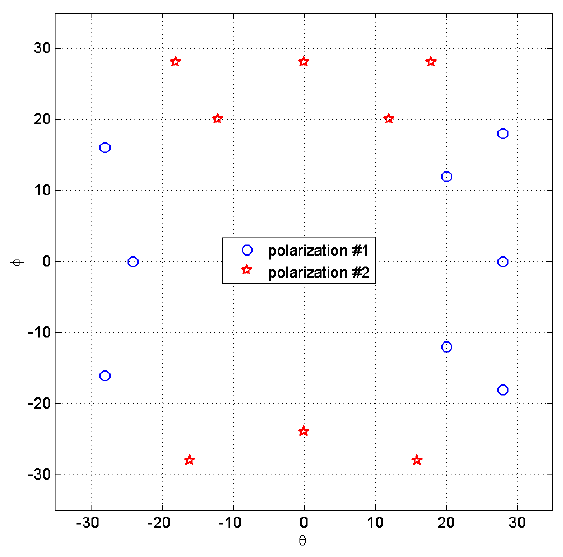
Figure 10. Main lobe directions achievable by means of the proposed antenna, in both